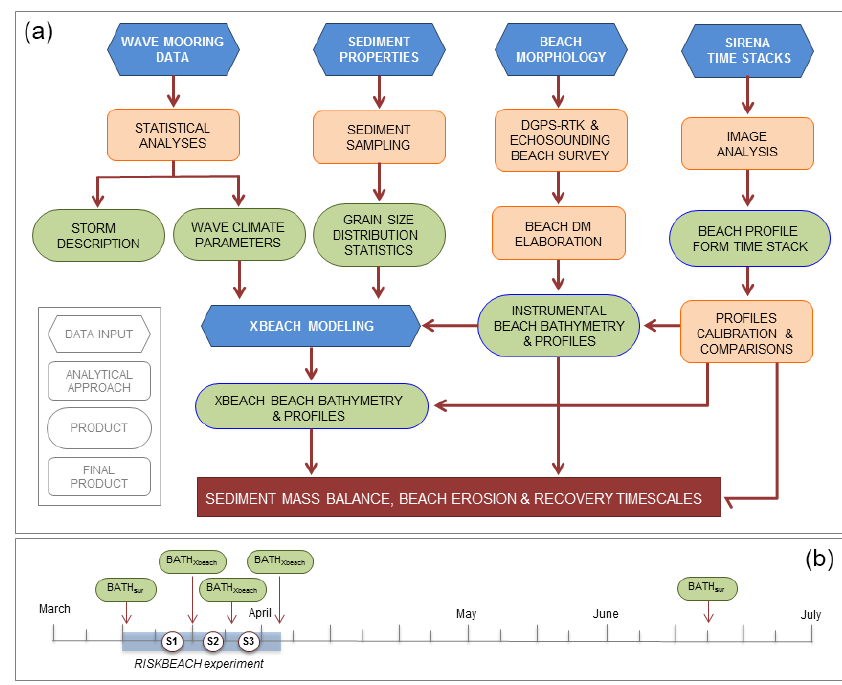
Figure 3. (a) Workflow of the approach followed in the study. (b) Calendar showing the date for the samples used in the study.